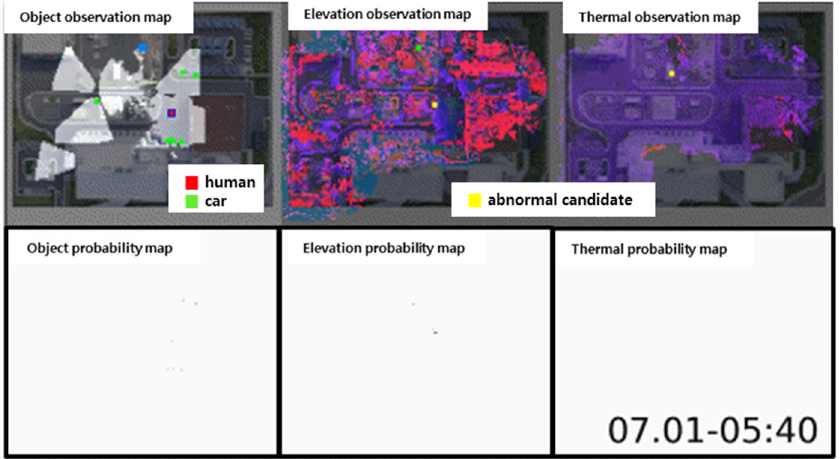
Figure 20. Example of observation regions using multi-modal sensor module based fixed and mobile agents-based day/night surveillance system include abnormal probability.